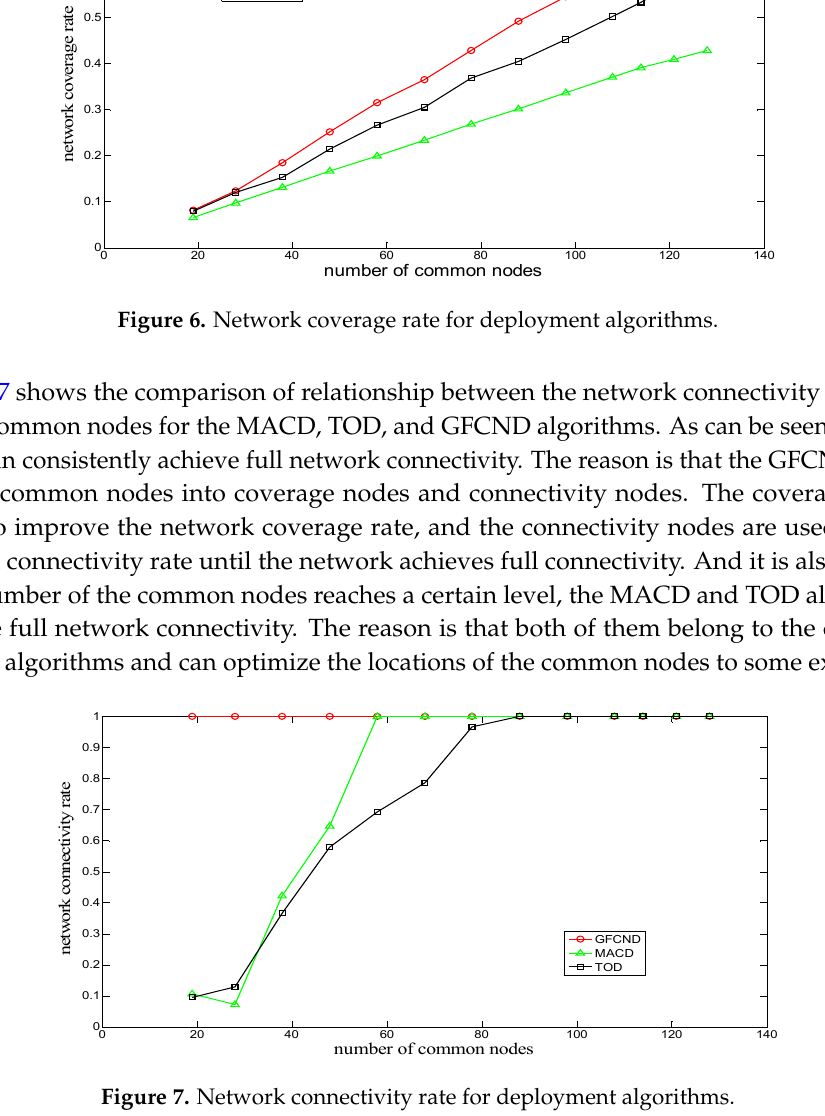
Figure 7. Network connectivity rate for deployment algorithms.